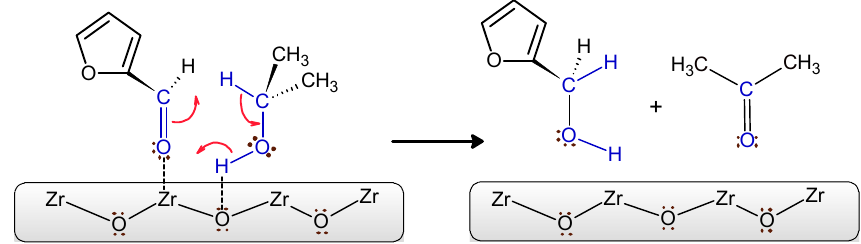
Figure 9. Suggested mechanism for furfural hydrogenation into furfuryl alcohol on acid–base pair sites in ZrO x through transfer hydrogenation from propan-2-ol.